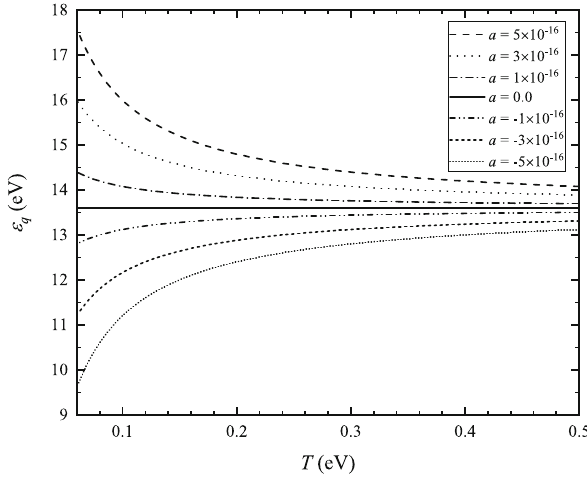
Fig. 1 The behavior of non-Gaussian binding energy as a function of temperature for some values of the a -parameter. This result takes into account that m e = 5 . 110 × 10 5 eV, m p = 9 . 383 × 10 8 eV, m H = 9 . 389 × 10 8 eV and ε 0 = 13 . 598 eV